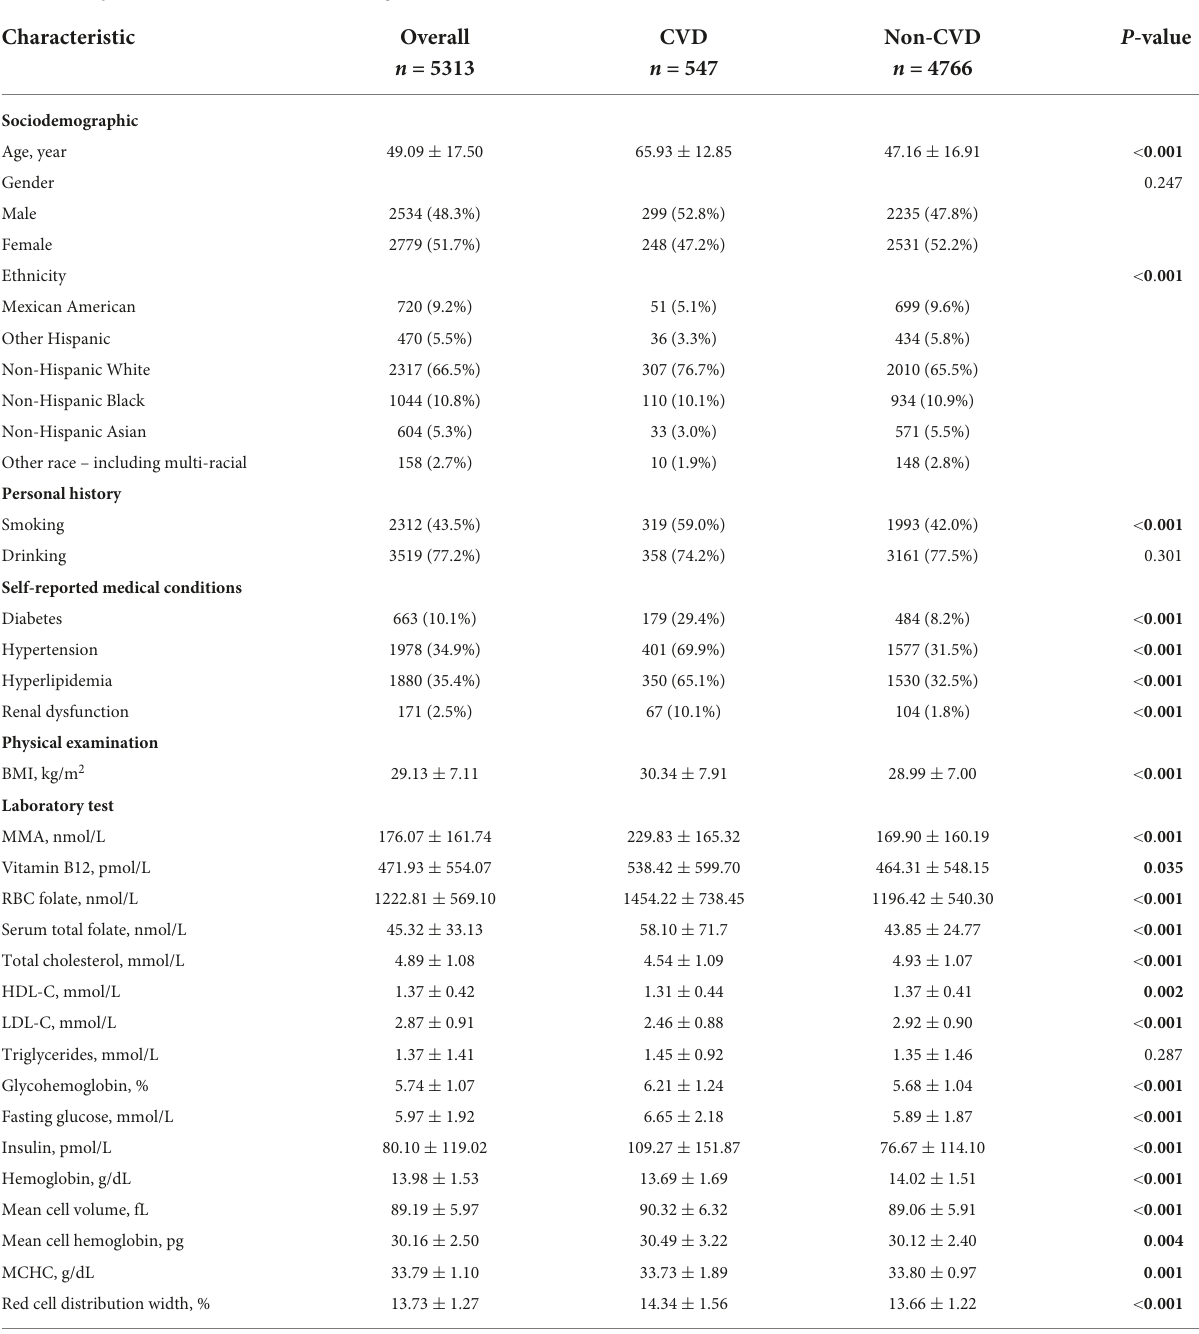
TABLE 1 Population characteristics stratified by